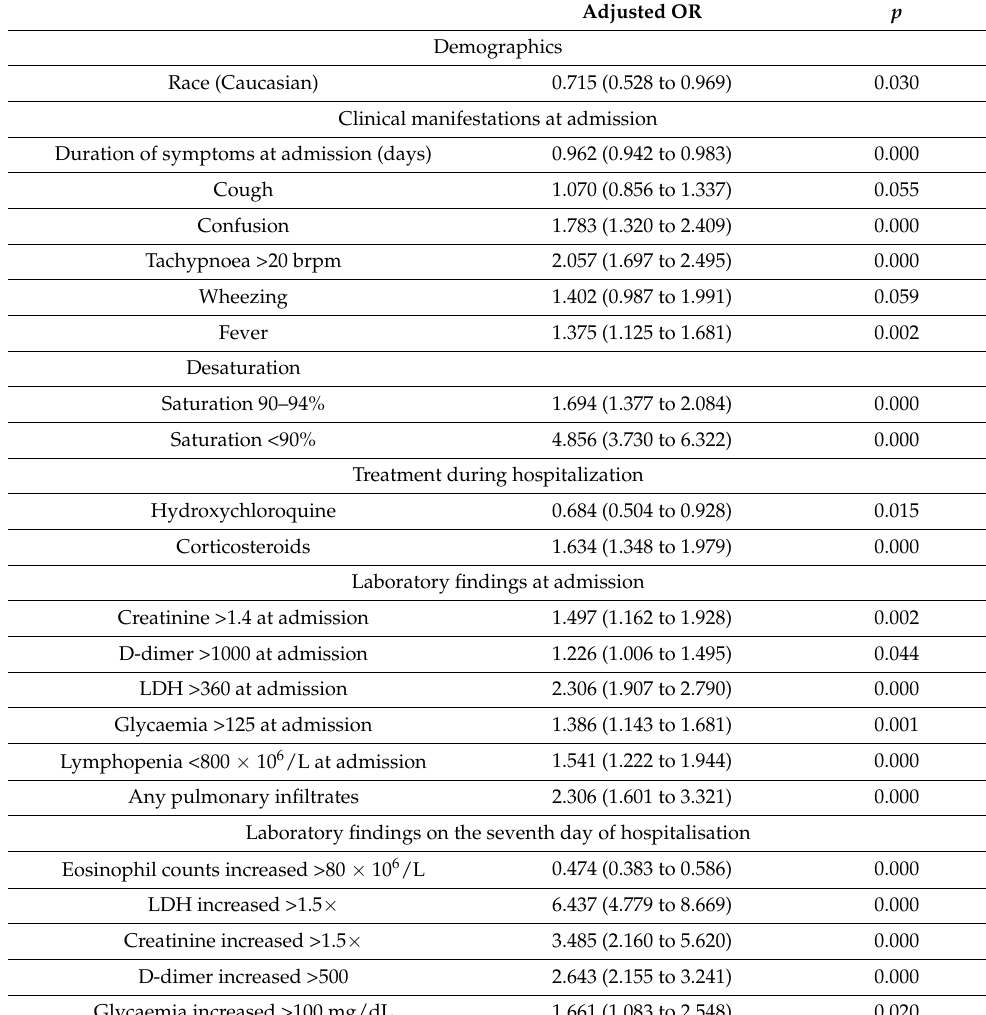
Table 5. Multivariate analysis of the composite endpoint of in-hospital death or ICU admission or moderate-to-severe ARDS. The effect of each factor is expressed as an adjusted odds ratio (CI